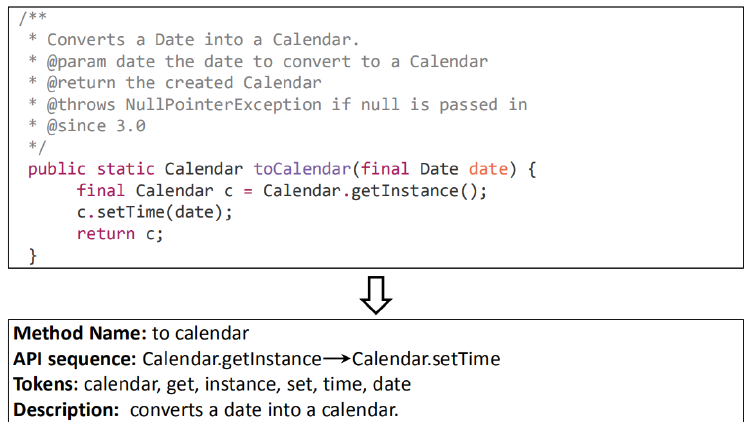
Figure 1. DeepCS code annotates the